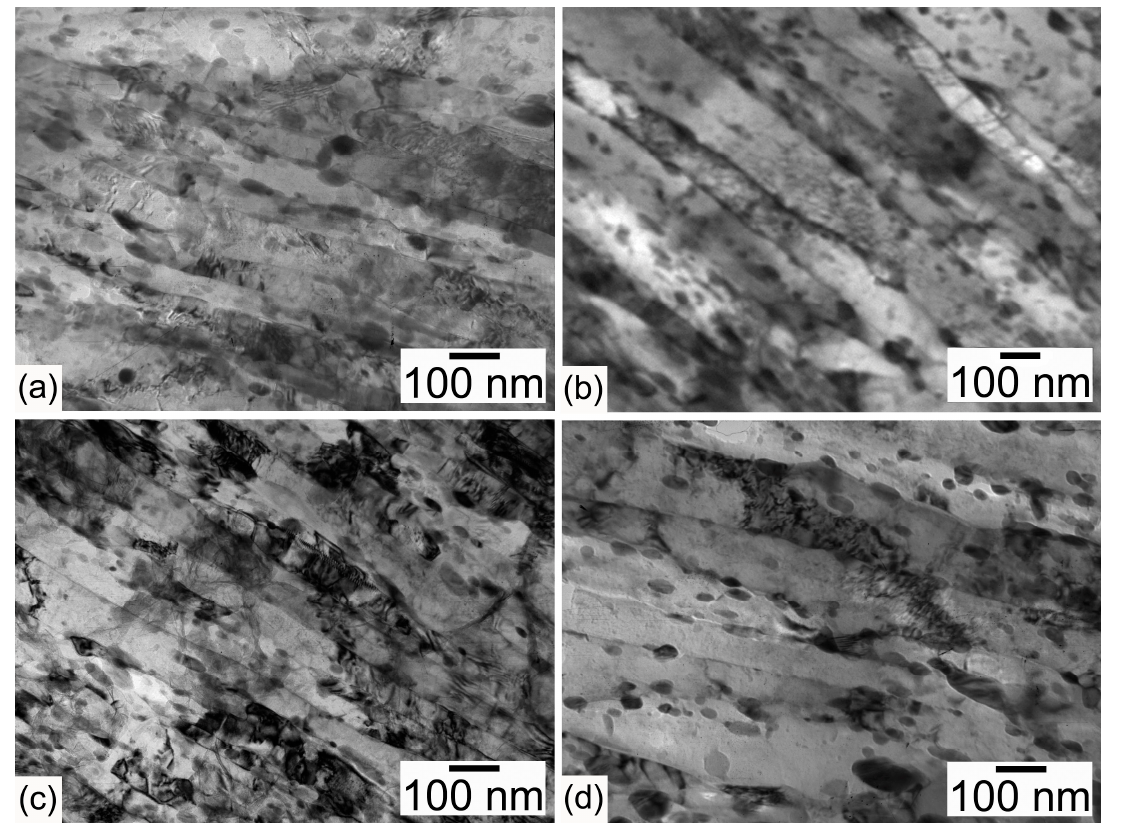
Figure 3. Typical TEM photographs of substructure in steel after tempforming at ( a , c ) 600 °C to total strains of ( a ) 0.89 and ( c ) 1.4 and at ( b , d ) 650 °C to total strains of ( b ) 0.5 and ( d ) 1.4. After tempforming at temperatures of 600 and 650 ° C with total strain of ~1.4, the Table 4. Microstructure parameters of steel processed by